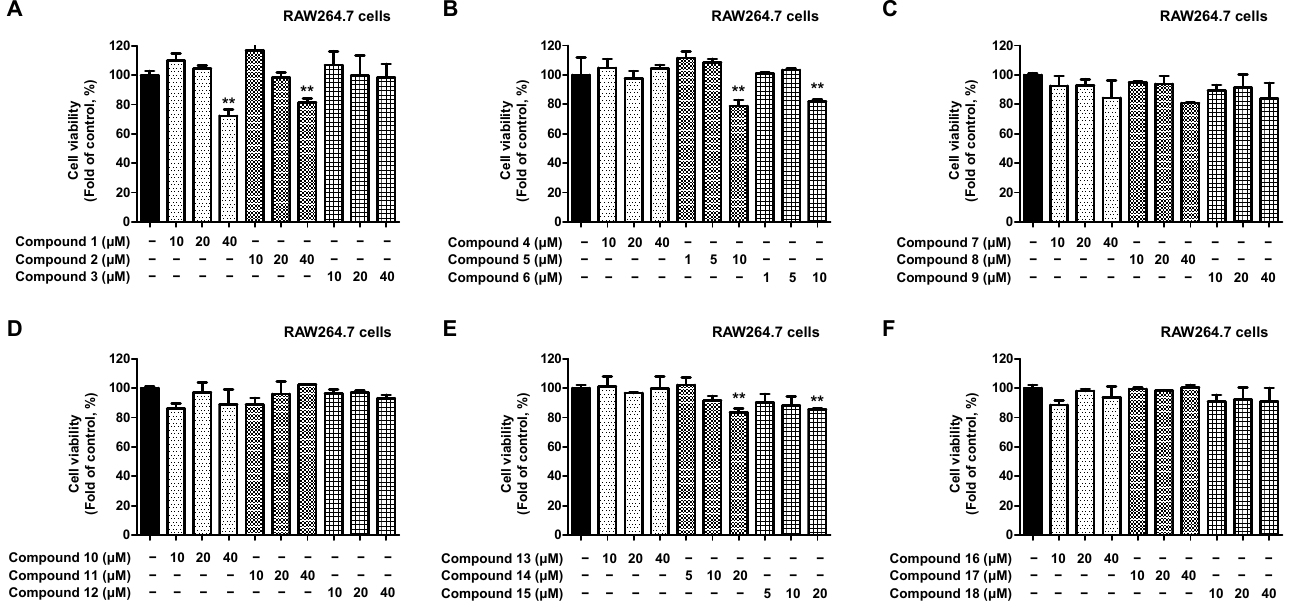
Figure 3. Cytotoxicity of the 18 natural compounds isolated from L. erythrocarpa leaves assayed in RAWA264.7 macrophage cells ( A – F ). Cytotoxicity was assessed after treatment with the compounds at concentrations of 1–40 μ M for 48 h. Data are presented as the mean ± standard deviation values of three independent experiments. ** p < 0.01 vs. control.